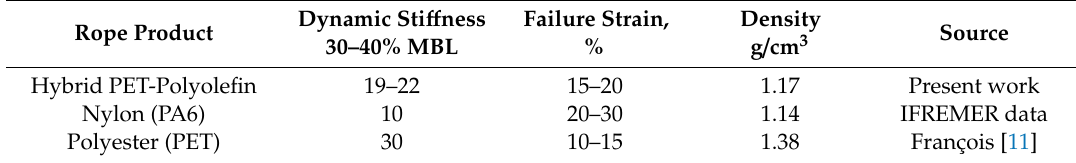
Table 6. Comparison of the hybrid polyester-polyolefin sample with properties of other fibre ropes. Rope product